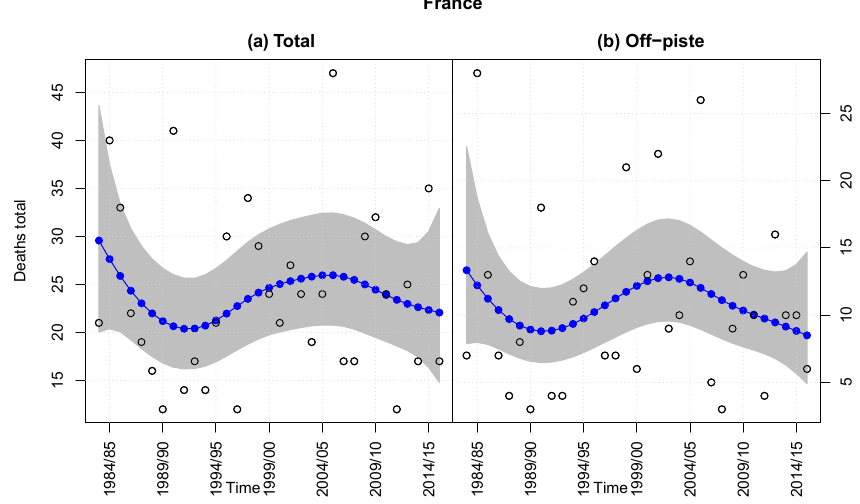
) annual avalanche fatalities – off-piste and backcountry, i.e., total, in (a) and off-piste in (b) – with Figure 4. Observed ( ◦ ) and estimated ( • 90% confidence bands (grey) in France within